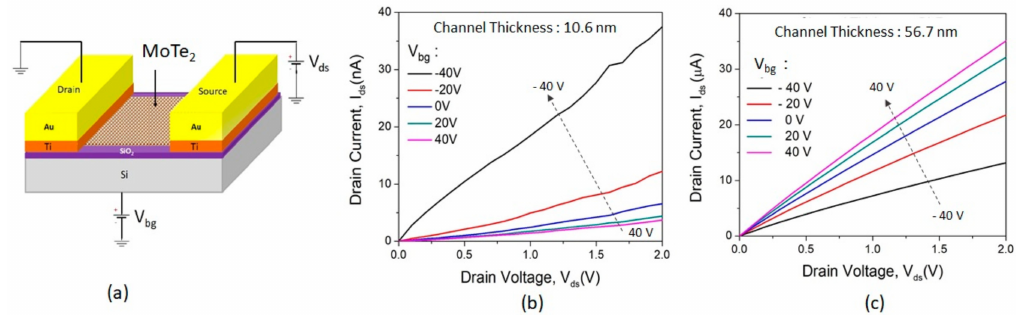
Figure 2. ( a ) Schematic of back-gate field-e ff ect transistor (FET) connection. Output characteristics of MoTe 2 FETs under di ff erent back-gate voltages, V bg . FETs with channel thickness of ( b ) 10.6 nm and ( c ) 56.7 nm showing p- and n-type conductivity,